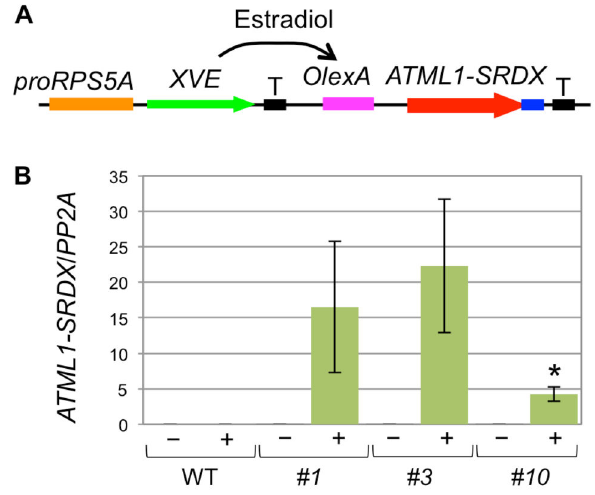
Figure 1. Estradiol-induced expression of ATML1- SRDX. (A) Representation of an estradiol-inducible gene DNA-binding domain/VP16 activation